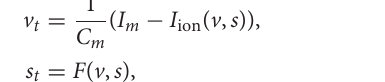
where R m represents the resistance of the passive membrane (in k (cid:127) cm 2 ) and v rest denotes the resting potential of the